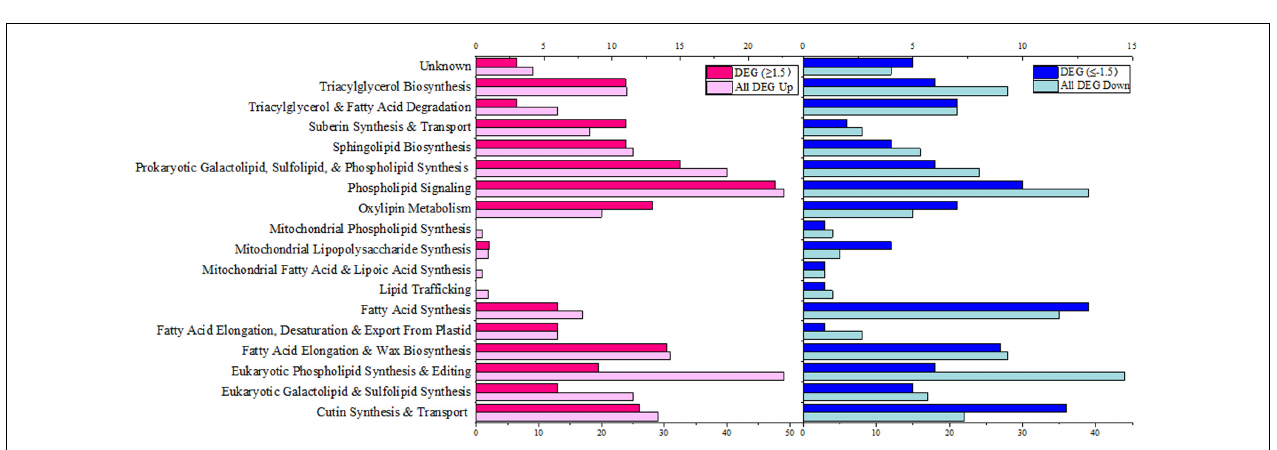
FIGURE 3 | Functional categorization of lipid-related genes from transcriptome of maize leaves (5 ◦ C vs. 22 ◦ C). Genes involved in lipid metabolism were compiled from the Arabidopsis lipid gene database (Beisson et al., 2003) and categorized based on different pathways. Pink columns represent down-regulated genes, and blue columns represent up-regulated genes. In each category, the light colored column represents the total differentially expressed genes (DEG), and the dark colored column represents the significantly differentially expressed genes (DEG, Log2FC ≥ 1.5 or ≤ –1.5). The number of the genes in each category were displayed in the x -axis (the ones on the upper x -axis indicate the DEG, Log2FC ≥ 1.5 or ≤ –1.5).